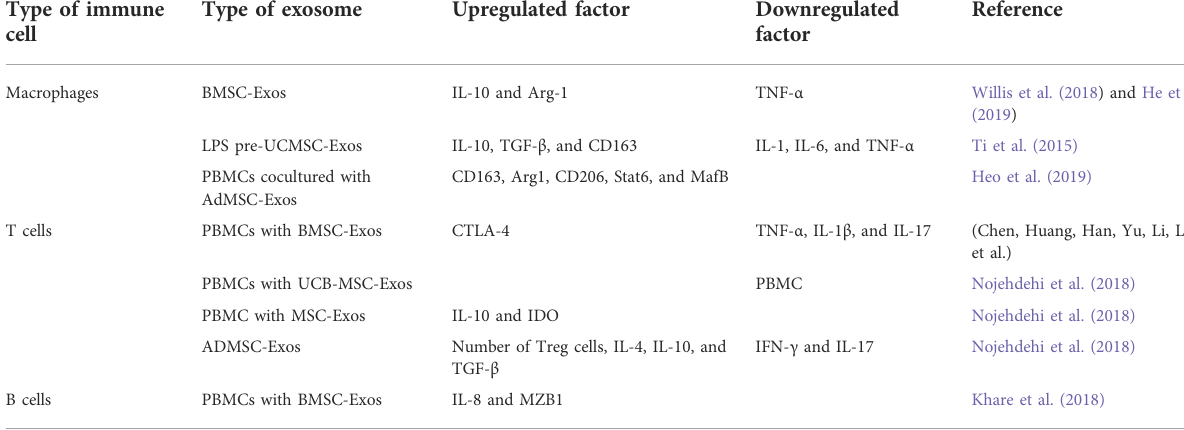
TABLE 2 Key variants in the anti-in fl ammatory